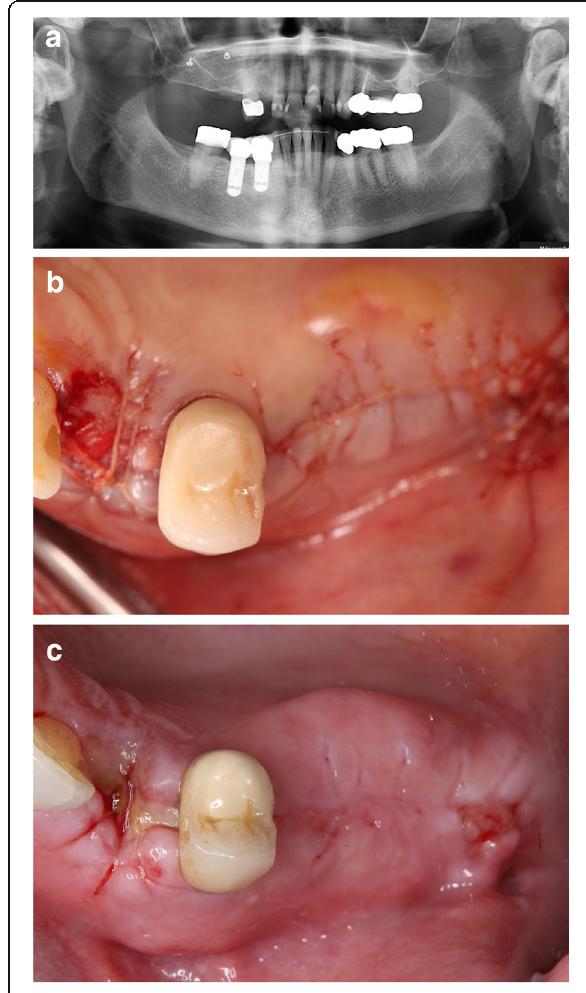
Fig. 3 a Post-operative panoramic X-ray. b Tension-free